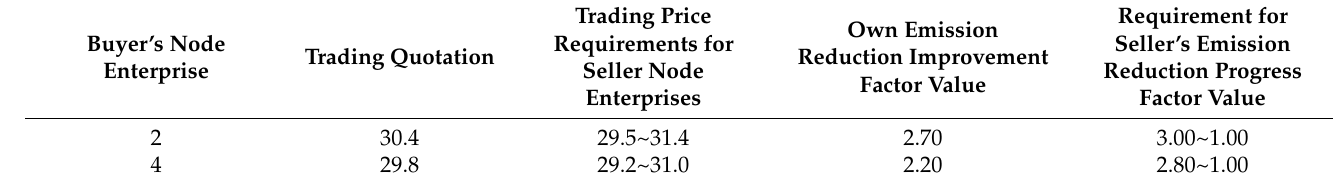
Table A7. Factor values of the buyer’s node enterprise and requirements for the seller’s node